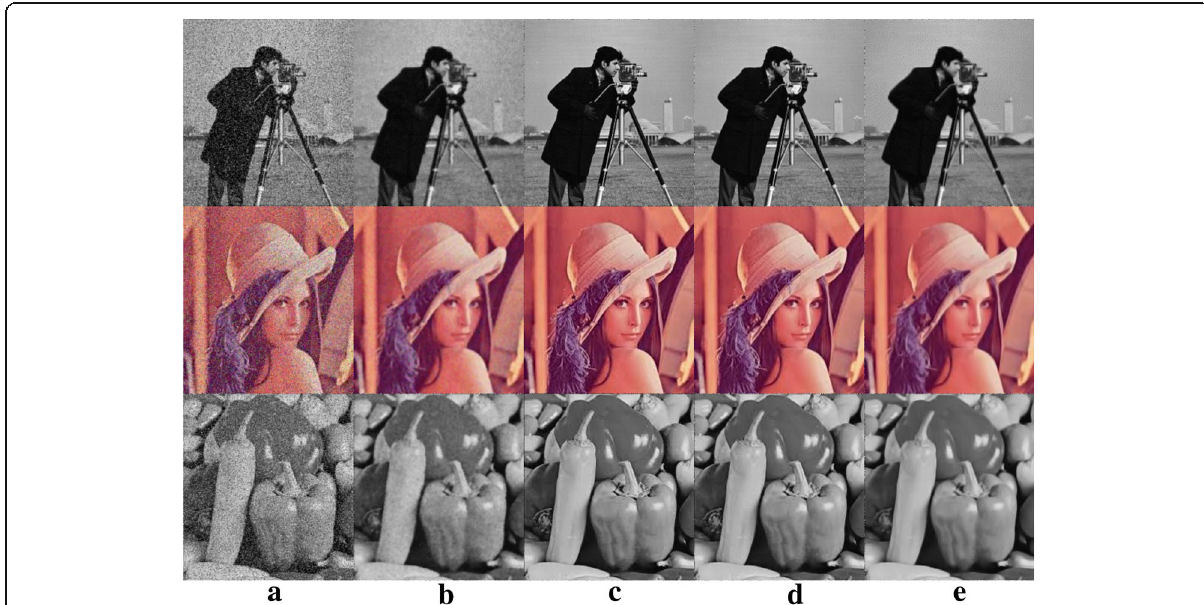
Fig. 2 Performance of a RF ( λ = 0.25), b AMD ( λ = 0.25), c AADF ( λ = 0.25), d FORADF ( λ = 0.25), e FORADF ( λ = 1) for salt and pepper noise at 20% density for n = 5. λ represents the control parameter, and n represents the number of